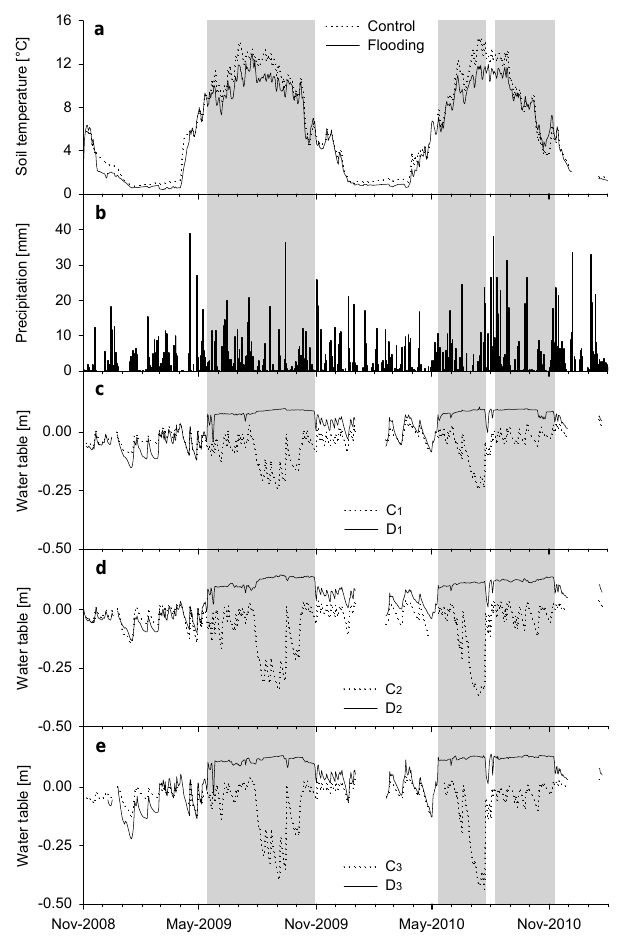
Fig. 2. Daily mean soil temperatures at 10 cm depth ( a ), precipitation ( b ) and water table levels ( c-e ) in the control (C) and flooded plots (D). Shaded areas mark the periods of experimental flooding with an interruption for technical reasons at the end of July 2010.